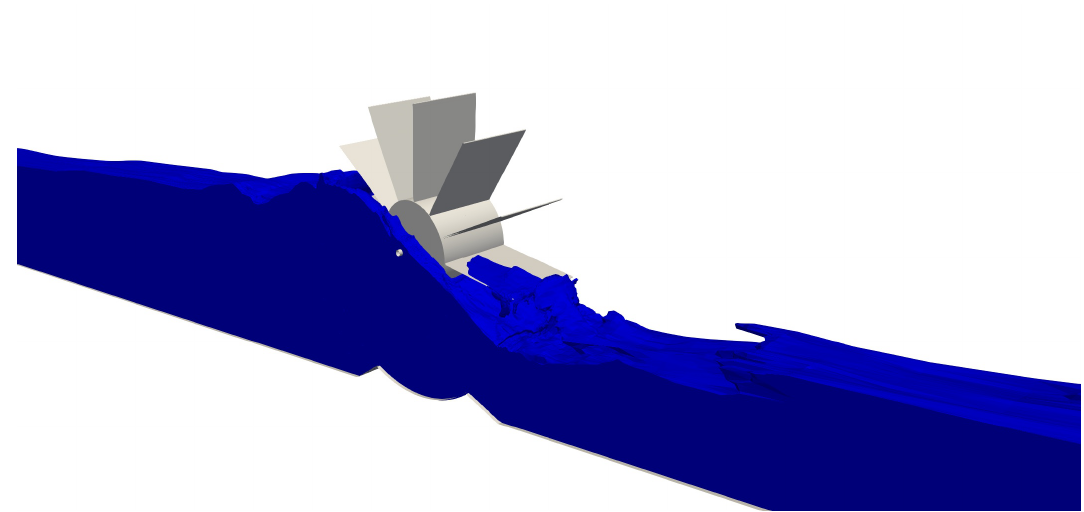
Figure 11. 3D image of water flow near the HPM, at time t = 4.0 s.